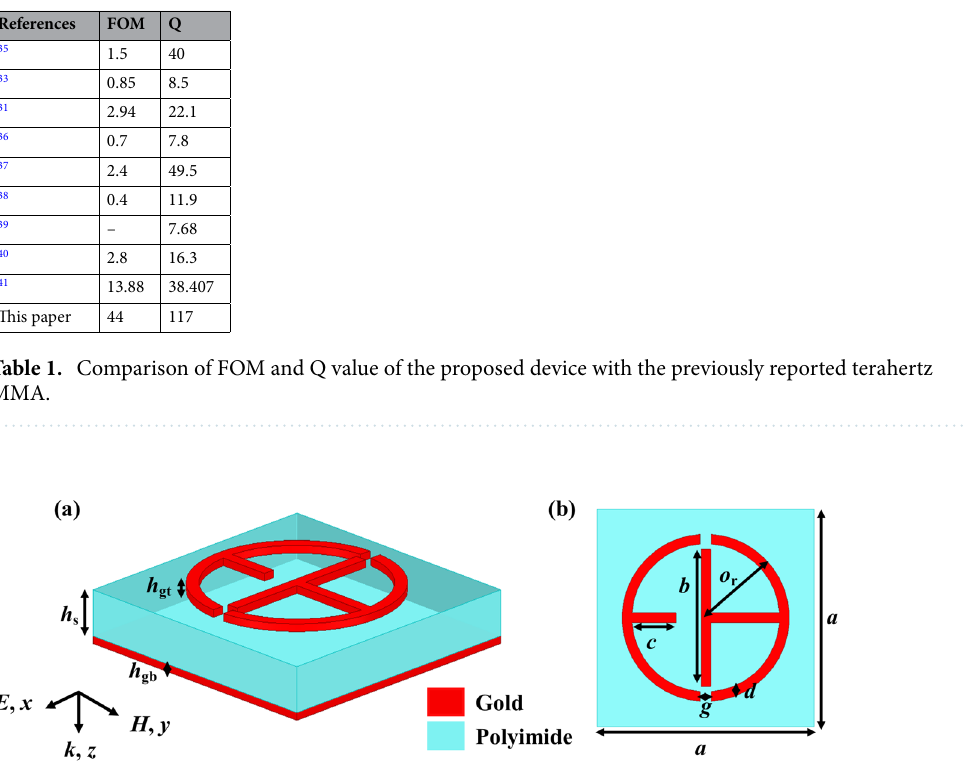
Figure 1. ( a ) Perspective view and ( b ) Top view of the proposed metamaterial absorber